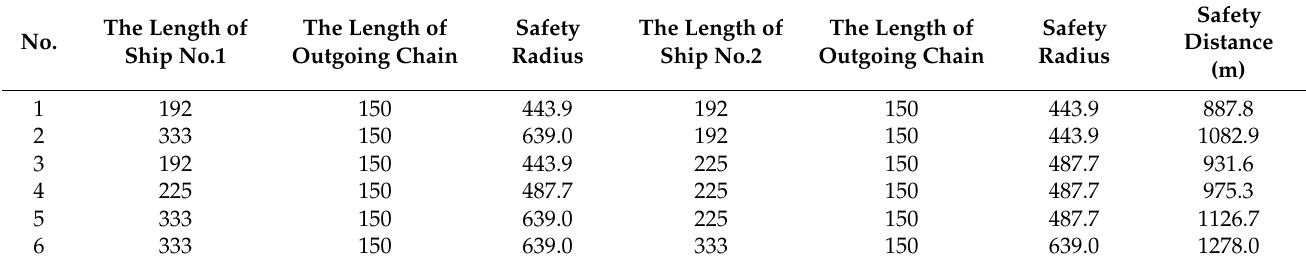
Table 5. Data of ships in safety distance with wind >7 (water depth 20 m) (unit: